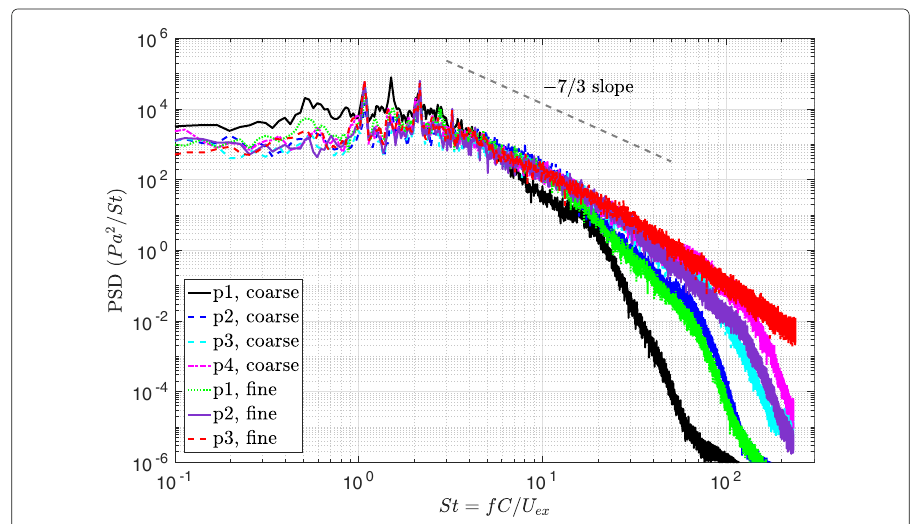
Fig. 7 Comparison of the PSD of pressure for all cases at wake point(2)